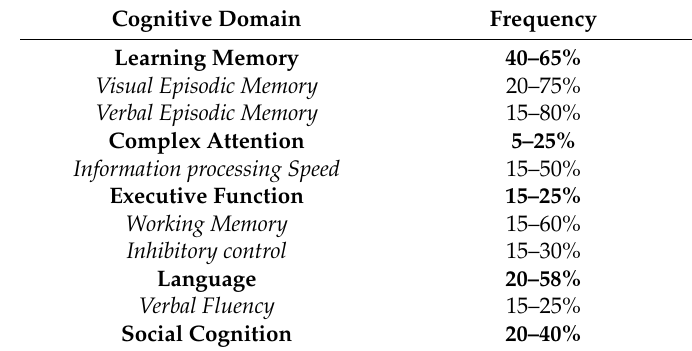
Frequency of cognitive impairment in patients with multiple sclerosis (MS) by cognitive